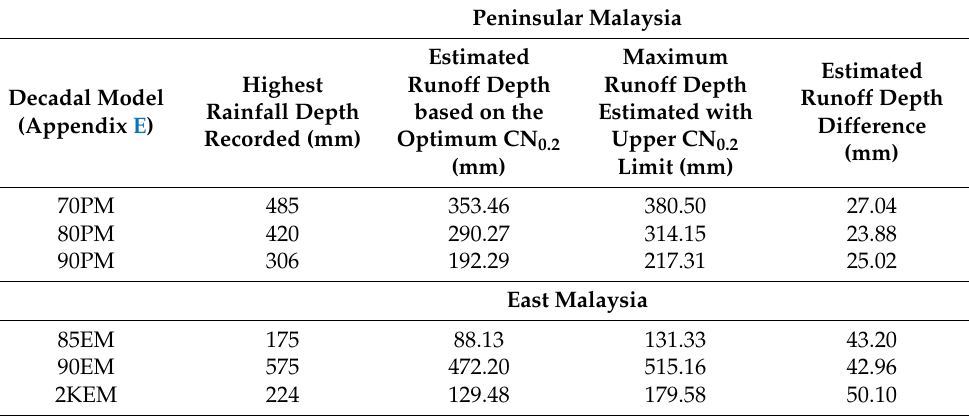
Table 6. The highest recorded rainfall depth, the runoff estimation obtained from the optimum CN 0.2 , the maximum runoff amount estimated based on the BCa 99% CI of CN 0.2 , and the runoff difference between both estimated results through each decade for both Peninsular Malaysia and East